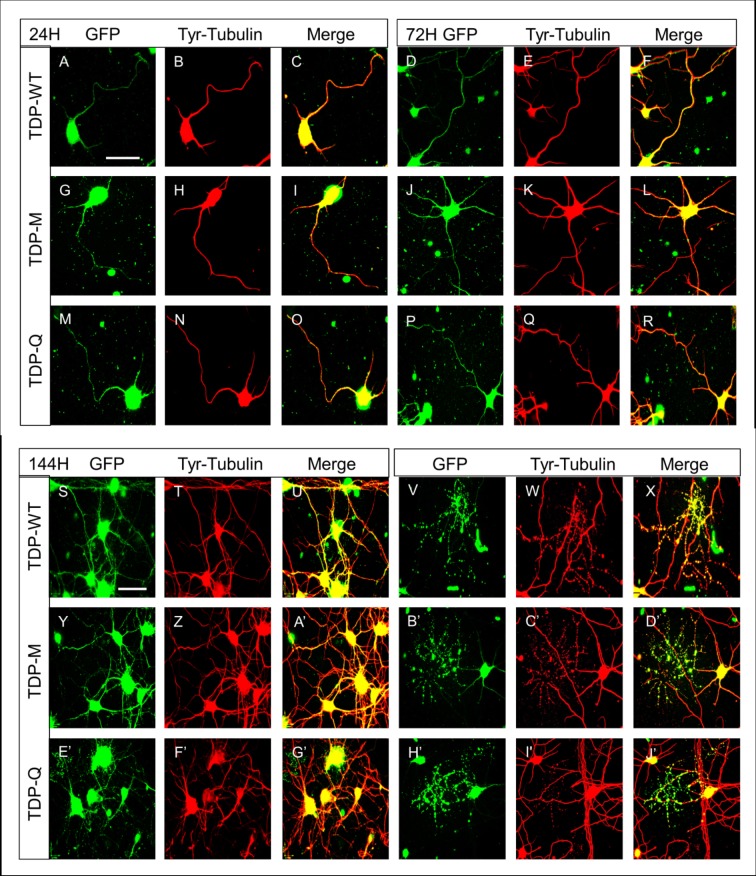
Cytoskeletal integrity is compromised over time in cortical neurons.Rat cortical neurons were transfected with GFP control, or GFP-tagged TDP-43 wild-type and mutant isoforms as labelled and analysed at 24, 72 H and 144 H. Immunostaining with anti-GFP (green) and anti-tyrosinated tubulin (red) antibodies. Cellular fragmentation was observed at 144 H (bottom right panel). Scale bar = 10 µm.